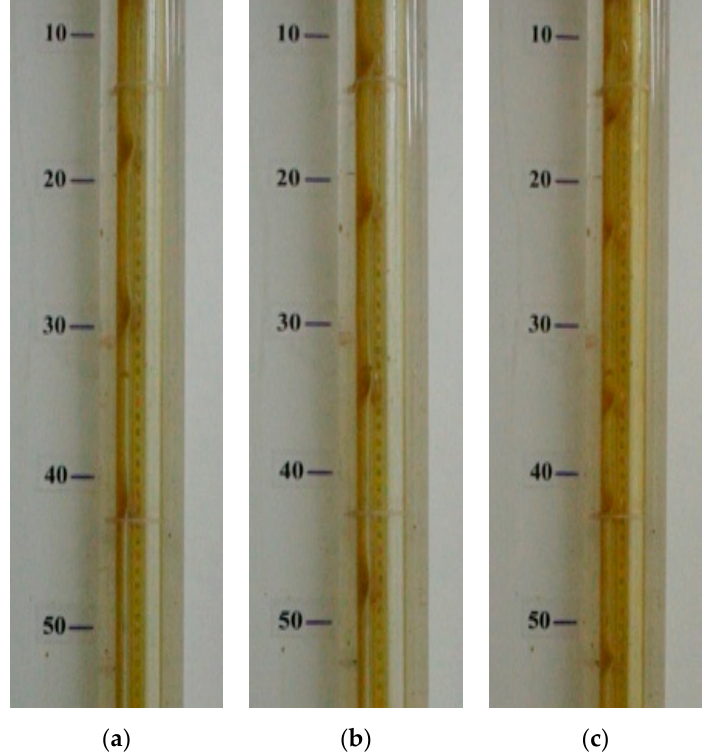
Figure 18. Changes in the wavy characteristics of interfacial surface resulting from the variations in liquid properties accompanying its heating for j l = 0.014 m / s, and η l = 0.37–0.90 Pas. ( a ) j g = 0.8 m / s; ( b ) j g = 1.12 m / s; ( c ) j g = 1.55 m /